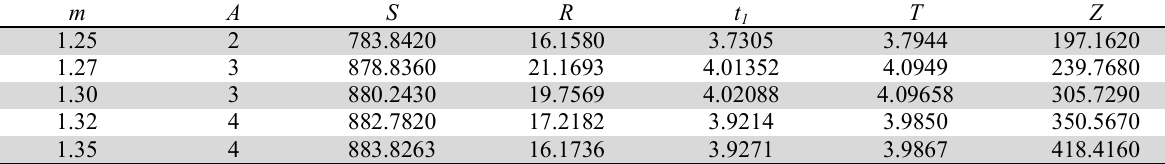
Optimal solution for different values of mark-up rate